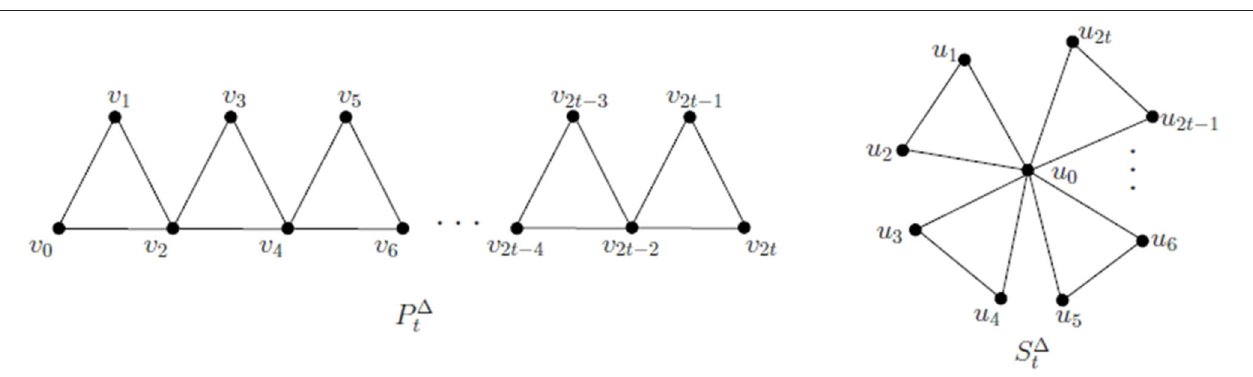
FIGURE 2 | The 3–cactus networks P △ t and S △ t